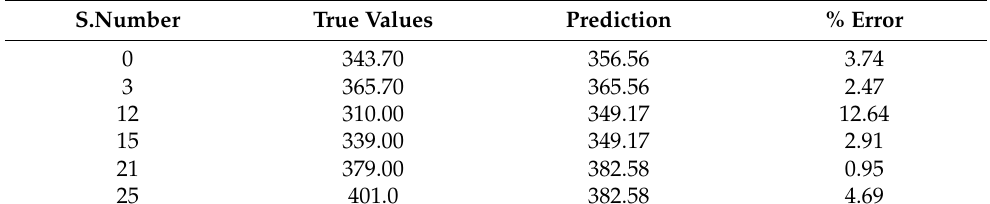
Table 6. Testing predictions vs true values.